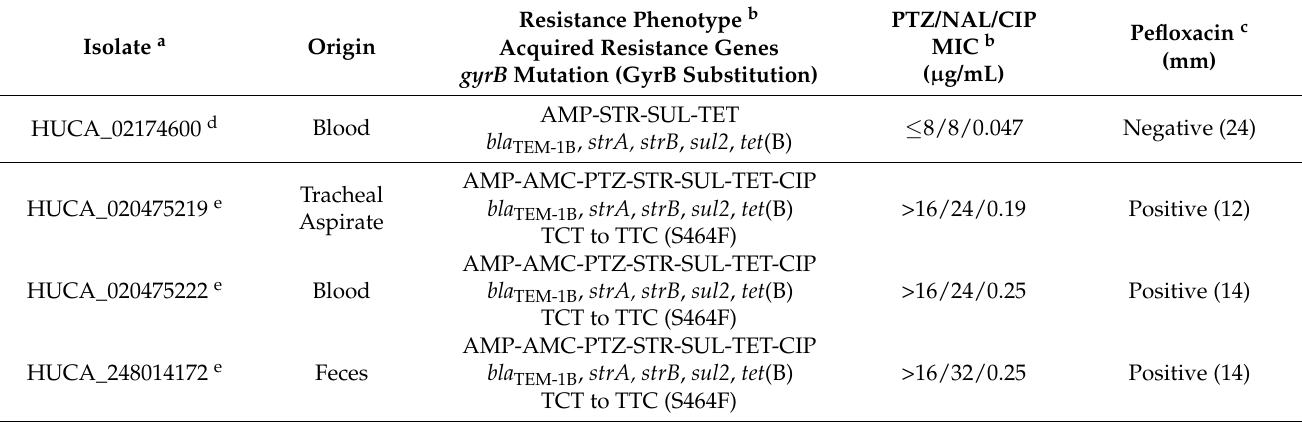
Table 1. Clinical and microbiological characteristics of monophasic (4,12:i:-) ST34 isolates of Salmonella enterica recovered in a Spanish hospital from a patient with